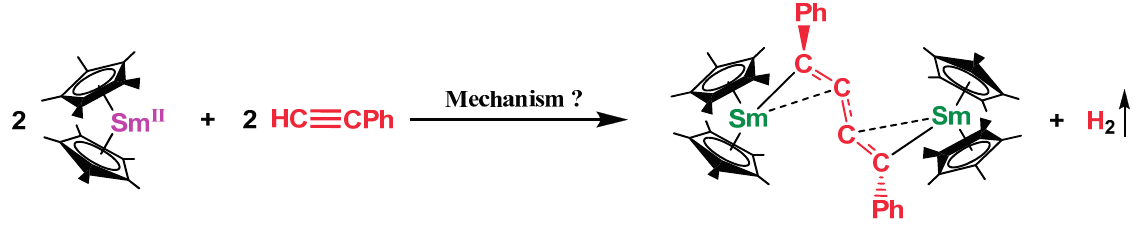
Figure 1. Reaction of samarocene with phenylacetylene to afford {[(C 5 Me 5 ) 2 Sm] 2 (µ- η 2 : η 2 - PhC 4 –Ph)} complex and H 2 .